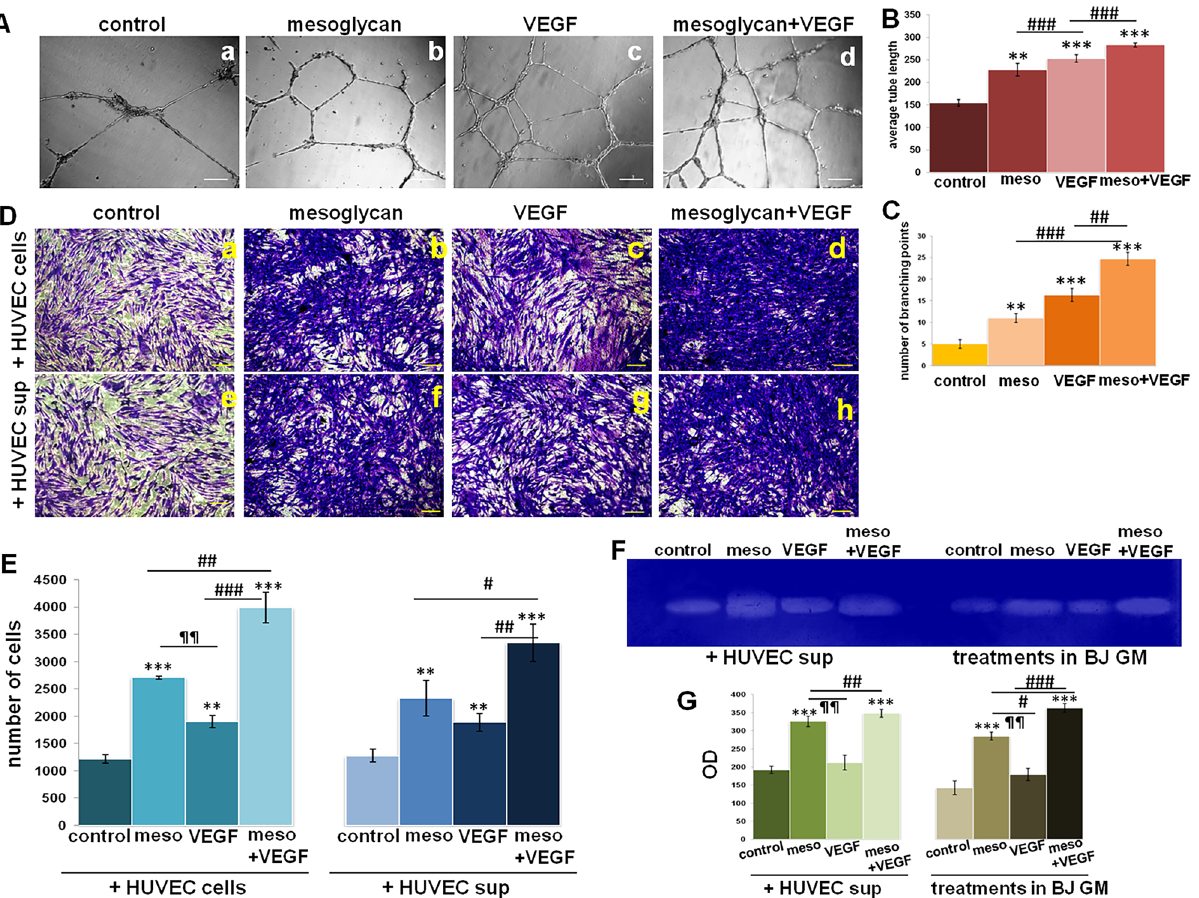
Figure 1. ( A ) Representative bright field images of in vitro angiogenesis (panels a–d) and analysis of ( B ) tube length carried out the Openlab software and ( C ) the number of branches calculated by ImageJ (Angiogenesis Analyzer tool) software on HUVEC cells treated with mesoglycan (meso; 150 μg/ml) and VEGF (10 ng/ml) alone and together. Magnification ×10. Bar = 100 µm. Results of the invasion assay on BJ cells in presence, in the lower chamber, of HUVEC cells pretreated for 24 h with mesoglycan (meso; 150 μg/ml) and VEGF (10 ng/ ml) alone and together (panels a–d) and of supernatants harvested from HUVEC cells pretreated for 24 h mesoglycan (meso; 150 μg/ml) and VEGF (10 ng/ml) alone and together (panels e–h). Both ( D ) representative images and ( E ) the analysis of the number of cells have been reported. Magnification ×20. Bar = 150 μm. ( F ) Gelatin zymography showing increased gelatinolytic activity of MMP-2 of BJ cells. ( G ) Densitometry analysis of the intensity of lanes calculated respect the sample volume which was the same for every experimental point. All the data represent a mean of n = 3 independent experiments ± SD based on one-way ANOVA and a two-tailed Student’s t -test as appropriated, *p < 0.05, **p < 0.01, ***p < 0.001 versus untreated control; # p < 0.05; ## p < 0.01; ### p < 0.001 versus mesoglycan or VEGF single treatment; ¶¶ p < 0.01 for VEGF treatment versus mesoglycan